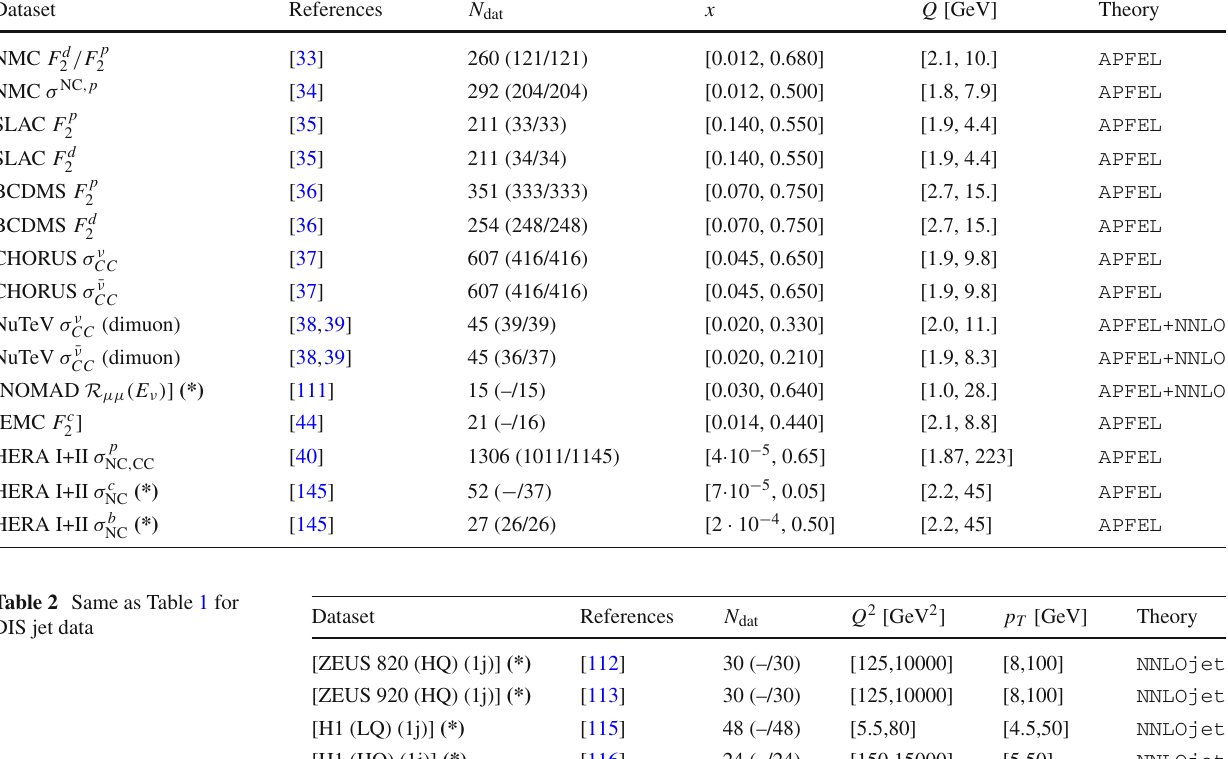
Table 1 The DIS datasets analyzed in the NNPDF4.0 PDF determina- tion. For each of them we indicate the name of the dataset used through- out this paper, the corresponding reference, the number of data points in the NLO/NNLO fits before (and after) kinematic cuts (see Sect. 4), the kinematic coverage in the relevant variables after cuts, and the codes